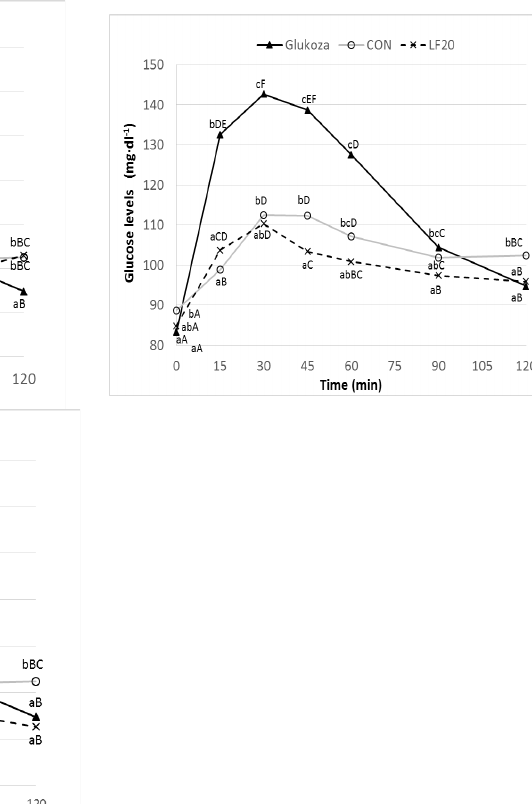
Figure 1. Uncooked (above) and cooked (below) pasta samples; Explanation: CON, control sample; LF, lupin flour; LFM, lupin flour and millet.